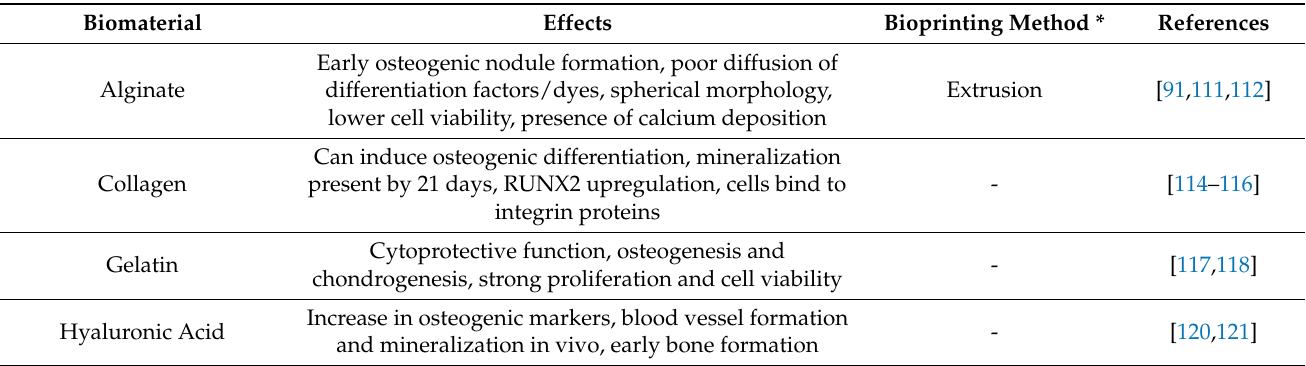
Table 4. Bone marrow stem cells in